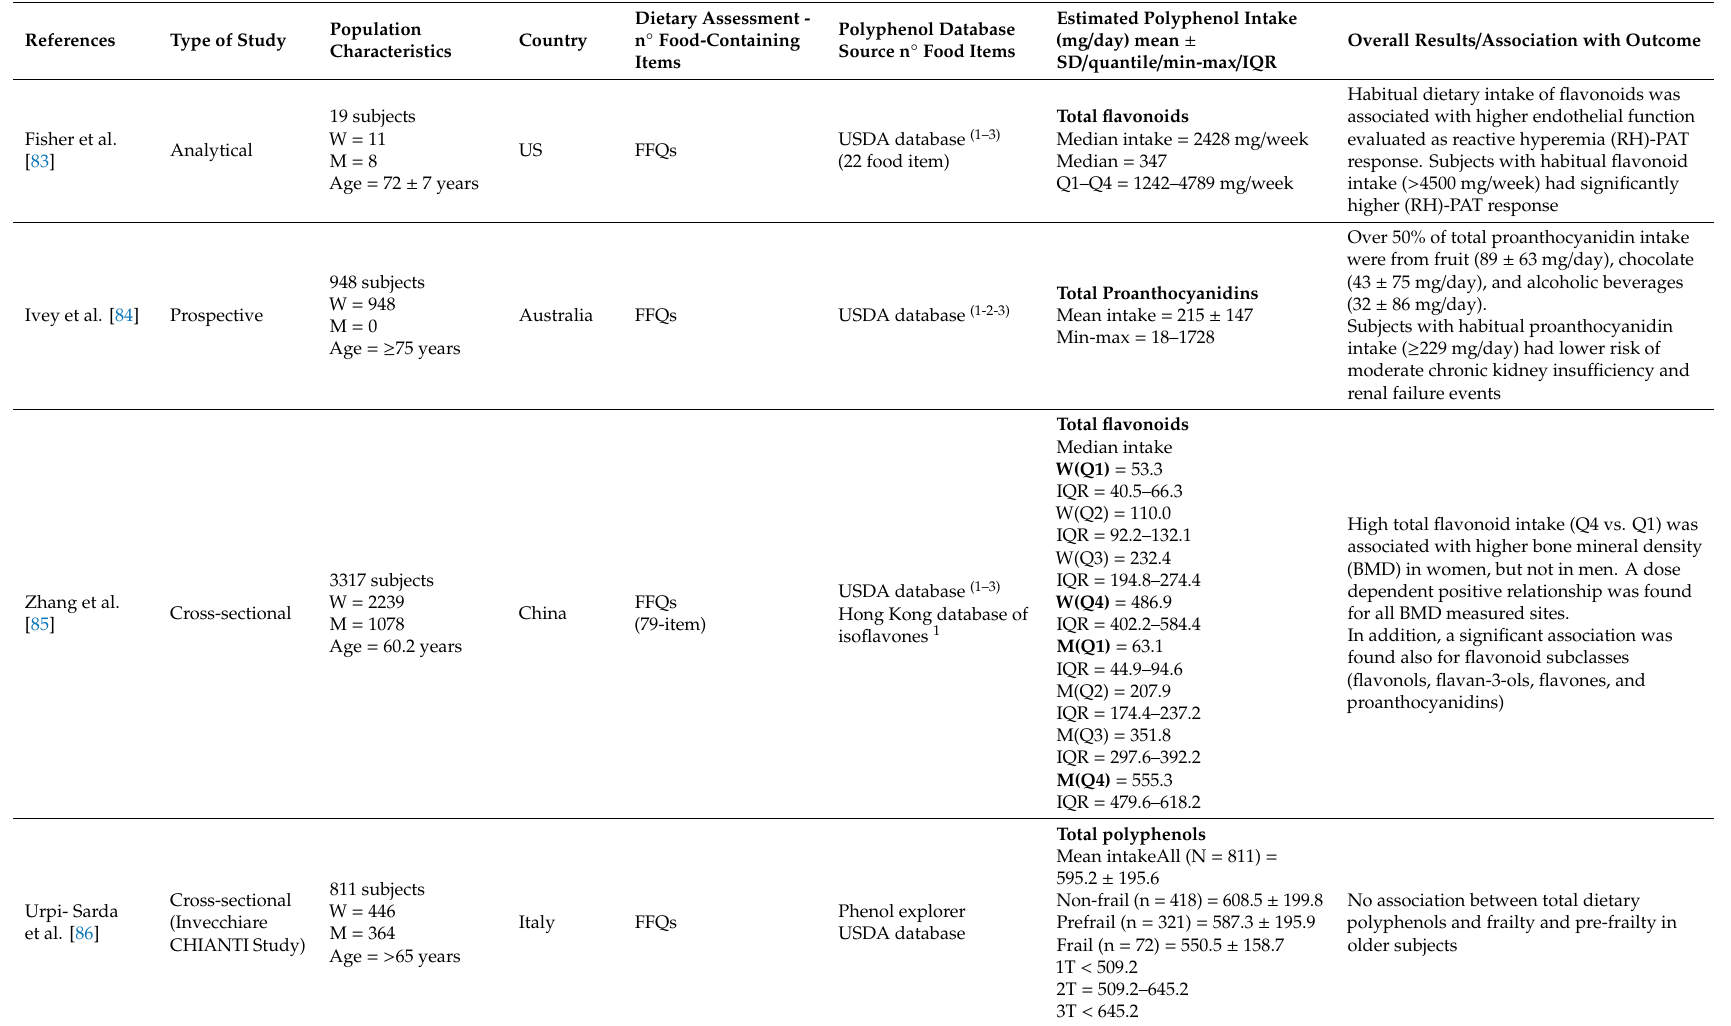
Table 4. Polyphenol intake and other